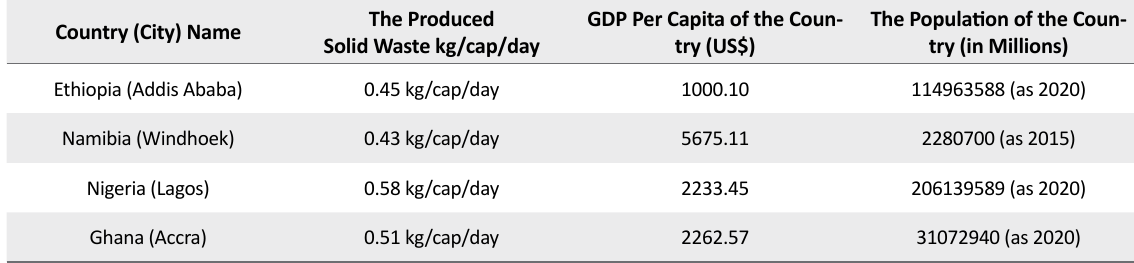
Table 2. Each country’s solid waste generation rate [5, 13, 22] Country (City)